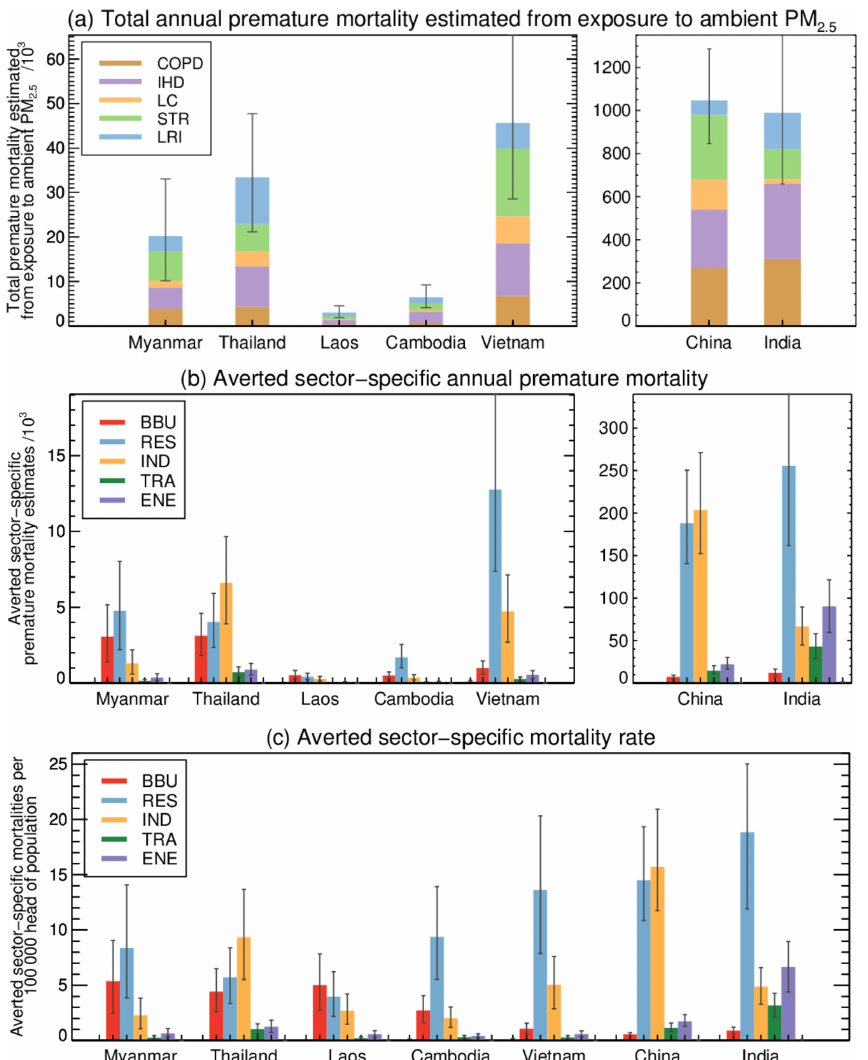
Figure 6. (a) Total annual premature mortality per country due to long-term exposure to ambient PM 2 . 5 from all emission sources. The colours show premature mortality by disease (chronic obstructive pulmonary disease (COPD), ischaemic heart disease (IHD), stroke (STR), lung cancer (LC), and lower respiratory infection (LRI)). (b) The number of averted annual premature mortalities due to a reduction in exposure to ambient PM 2 . 5 , achieved by eliminating emissions from each sector individually (agriculture (AGR; India only), power gener- ation (ENE), industrial non-power (IND), residential energy use (RES), land transport (TRA), open biomass burning (BBU), and shipping (SHP; East Asia only)). Averted mortalities due to eliminating shipping emissions (in East Asia) and agricultural emissions (in India) are not visible on the plot scale and so are not displayed in the legend. (c) The number of averted annual premature mortalities per 100000 head of population. Error bars in (a) , (b) , and (c) represent 95% uncertainty intervals calculated from combining fractional errors in quadrature (see Sect. S1.1 in the Supplement). Mortality estimates for China include Hong Kong SAR, Macau SAR, and